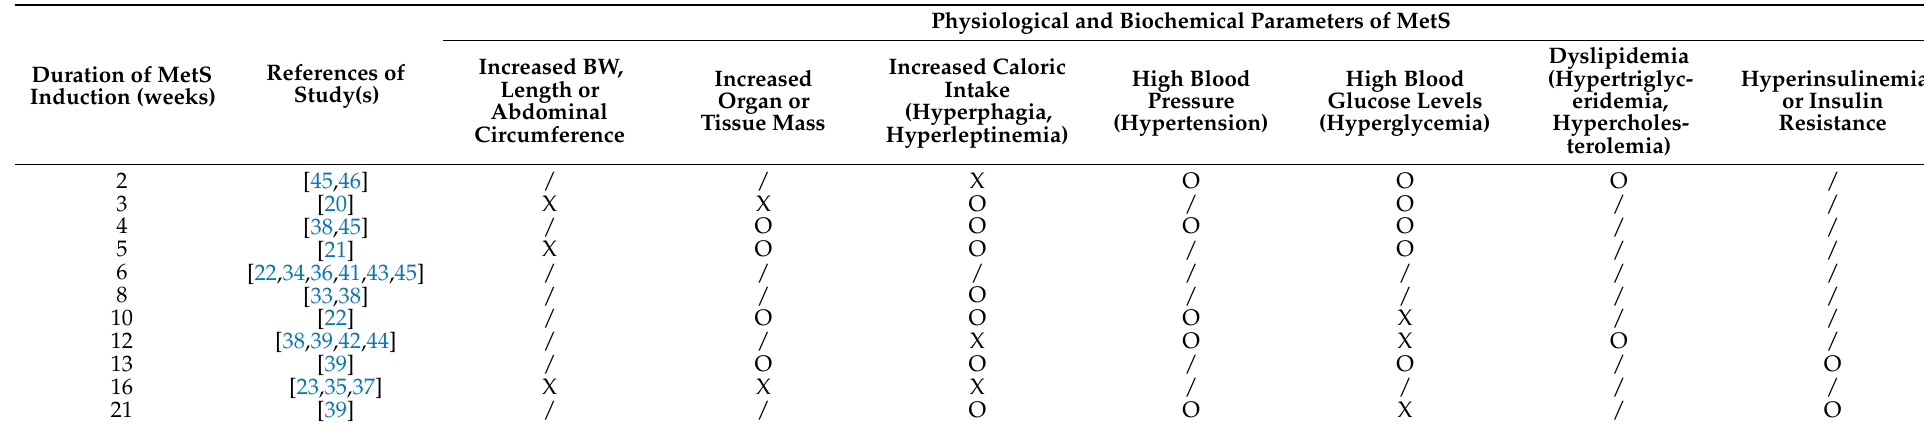
Table 3. Durations of MetS induction to physiological and biochemical outcomes of MetS.